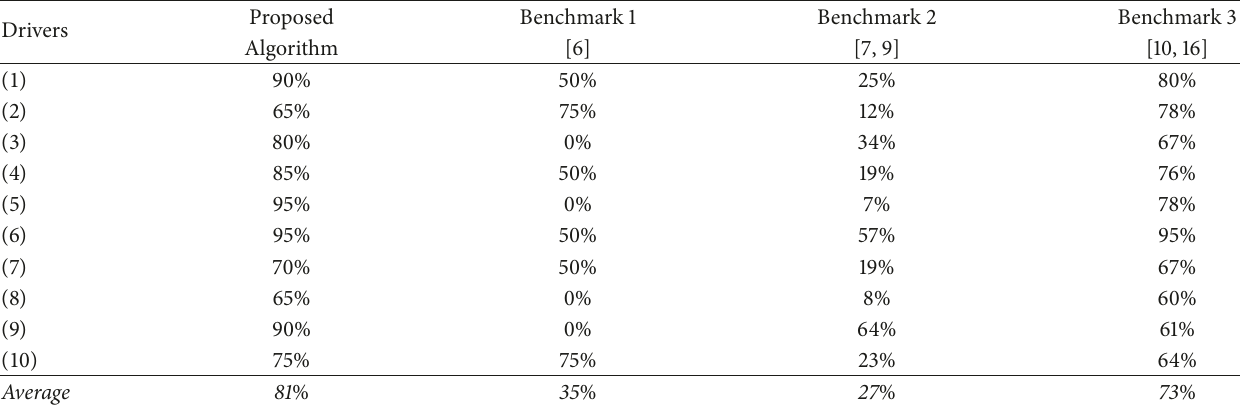
Table 6: Comparisons between the proposed algorithm and the benchmark algorithms in identifying drivers